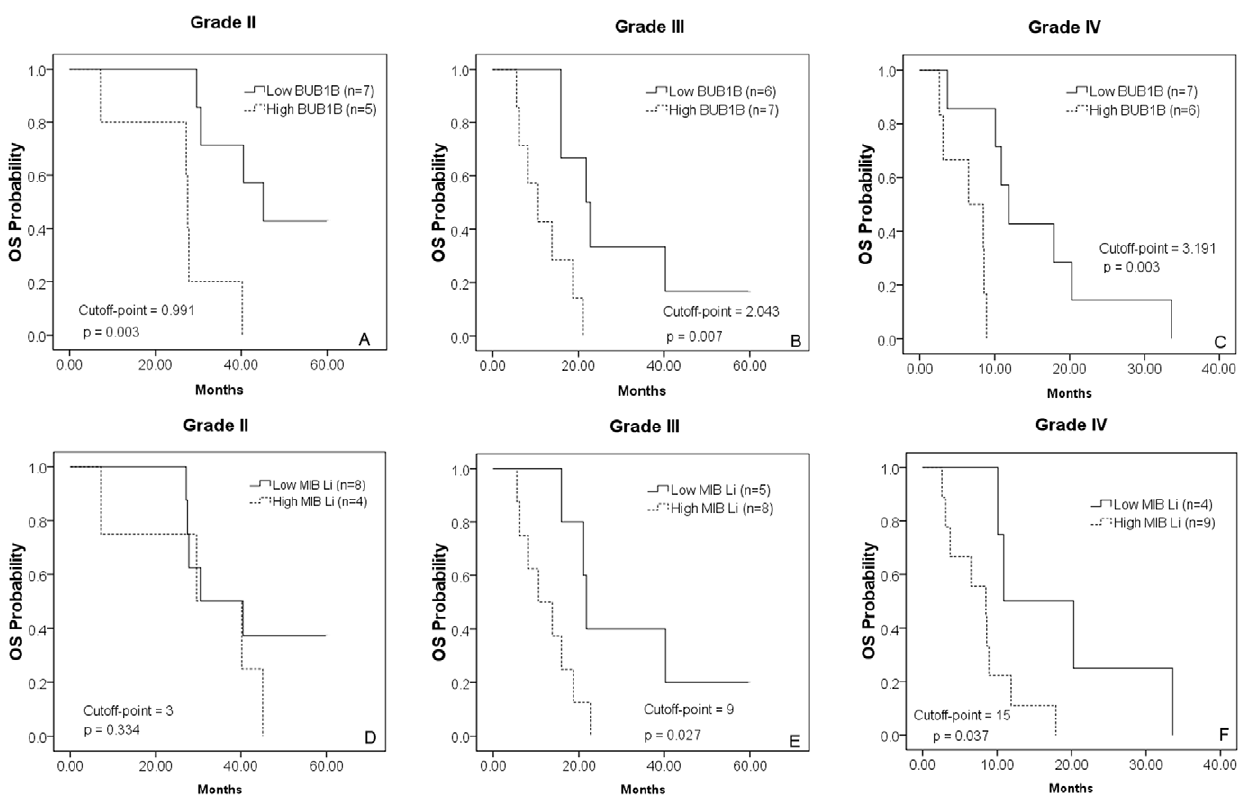
Figure 3. Kaplan-Meier estimates of overall survival time. Panels A, B, and C use BUB1BRNA expression as determined by qPCR. Panels D, E, and F use the MIB labeling index (MIB Li) that measures Ki-67 protein. Log-rank statistics is used to determine the cutoff-point, which is the expression value that divides low-expression samples from high-expression samples. OS=Overall survival.